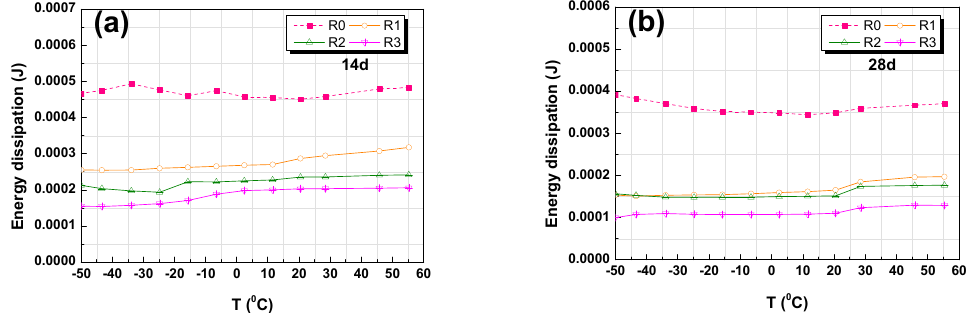
Figure 11. DMA analysis results of Energy dissipation versus temperature: ( a ) 14-day; and, ( b ) 28-day.